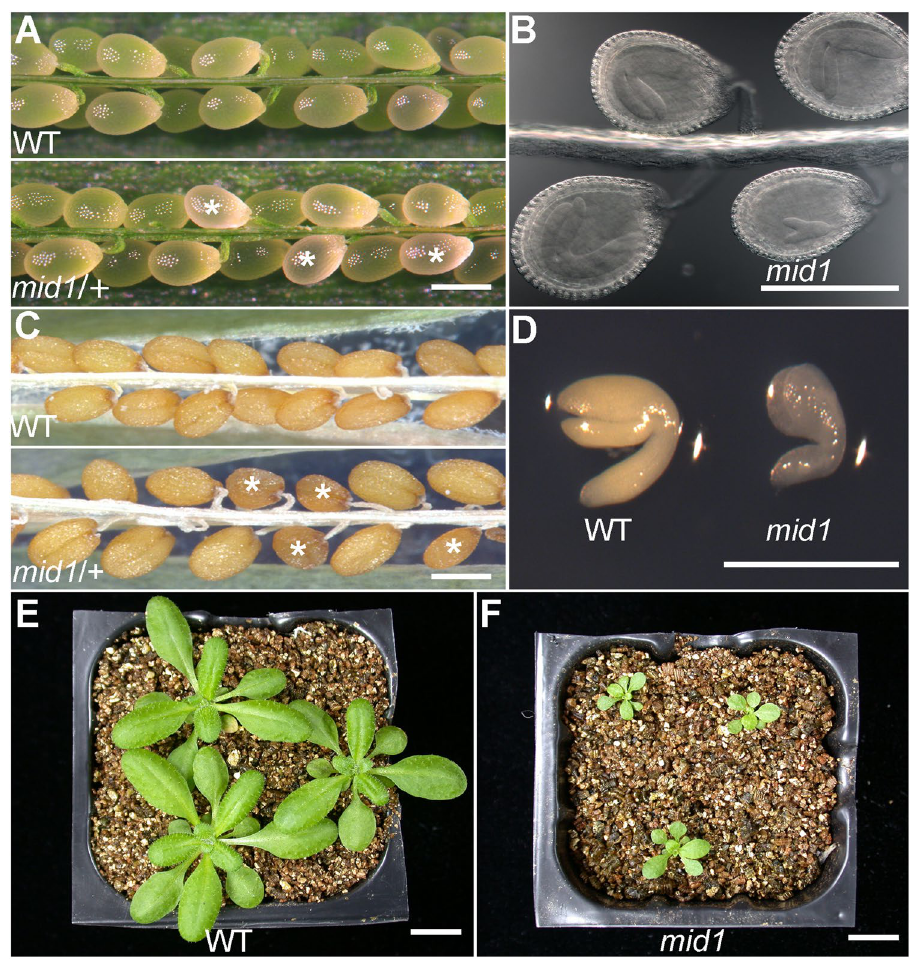
Figure 1. Phenotypes of mid1 . ( A ) Seed set of wild-type and mid1 / + siliques at 8 DPP. The wild-type shows a full seed set while approximately one-quarter of ovules in the mid1 / + silique are abnormal. Asterisks indicate the mid1 ovules. ( B ) Whole-mounted ovules from silique of mid1 / + plant in ( A ). ( C ) Seeds in the mature silique of wild-type and mid1 / + . Compared to the wild-type, about one-quarter of the seeds in mid1 / + display shrunken morphology. ( D ) Embryos dissected from mid1 / + plant. ( E ) 4-week-old wild-type plants. ( F ) 4-week- old mid1 plants. ( A , F ) Bars = 200 μ m; ( E , F ) Bars = 1